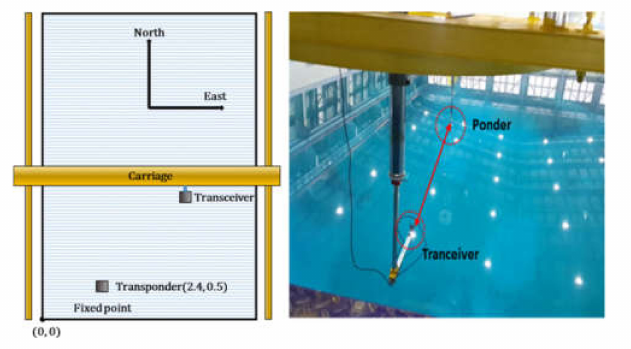
Figure 20. USBL test in engineering basin.